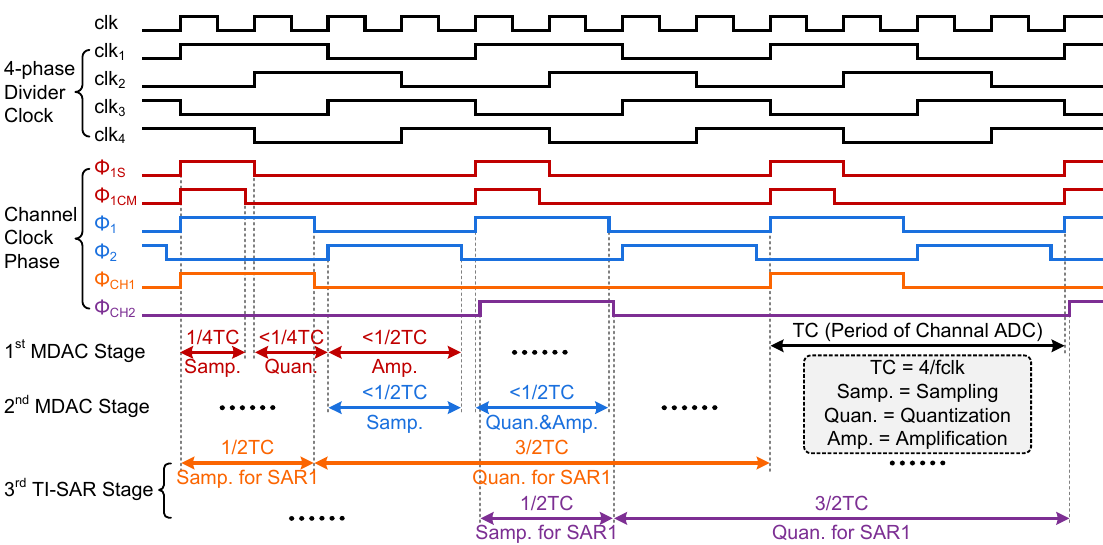
Figure 7. Timing diagram of the TI-ADC.